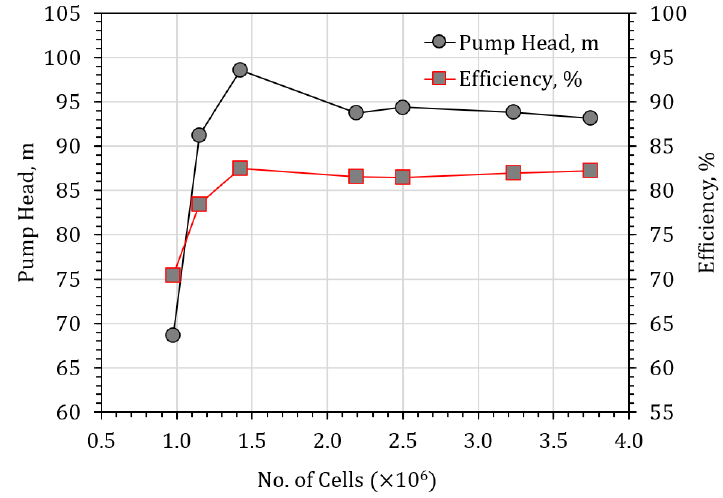
Figure 6. Pump head and efficiency results from grid sensitivity analysis.